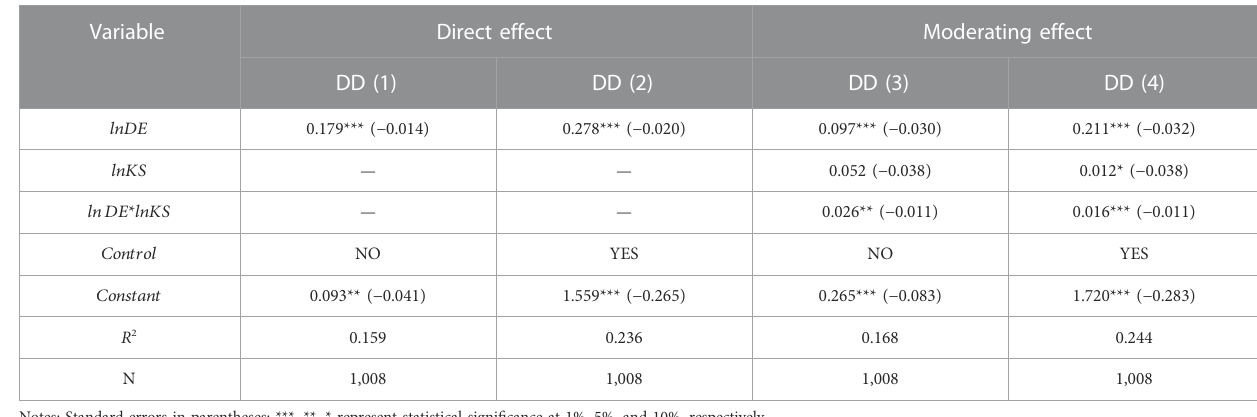
TABLE 4 Basic regression results.